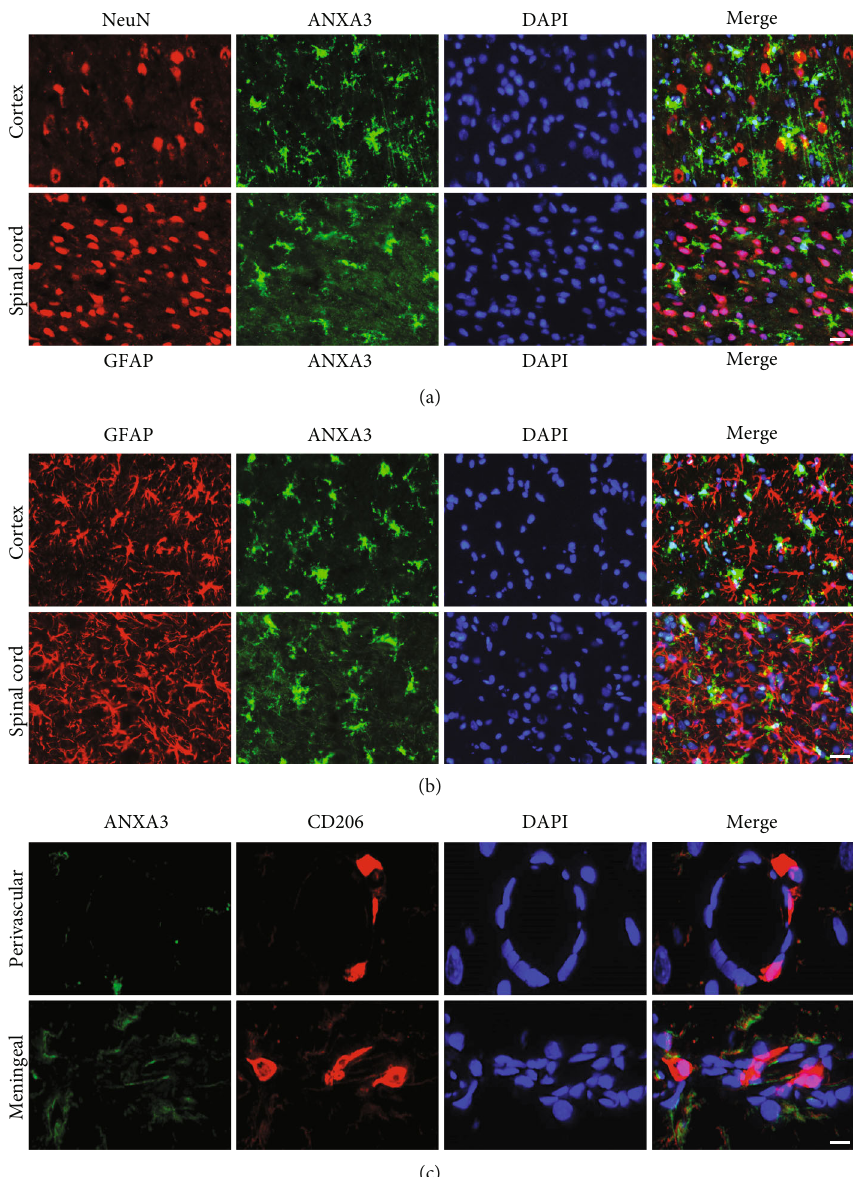
Figure 2: ANXA3 immunoreactivity in neurons, astrocytes, and nonparenchymal macrophages. (a, b) Representative immuno fl uorescence images showing the expression of ANXA3 in neurons (stained with NeuN) and astrocytes (stained with GFAP) from the cortex and spinal cord. Scale bar = 20 μ m . (c) Representative immuno fl uorescence images showing the expression of ANXA3 in macrophages labeled with CD206 in the perivascular and meningeal. Scale bar = 50 μ m